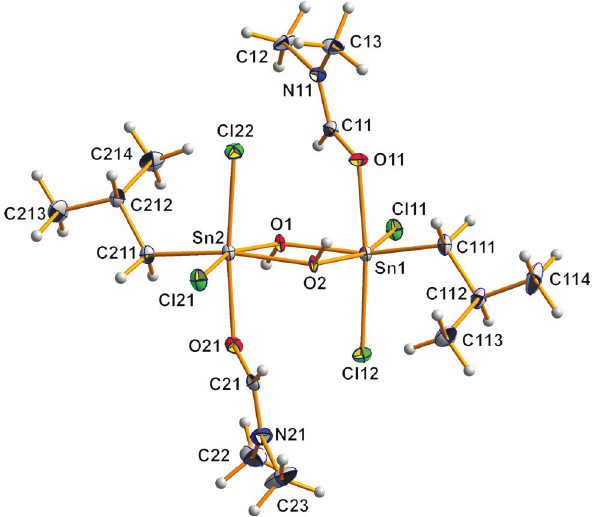
(OH)(DMF)] (molecule 1 ) 2 2